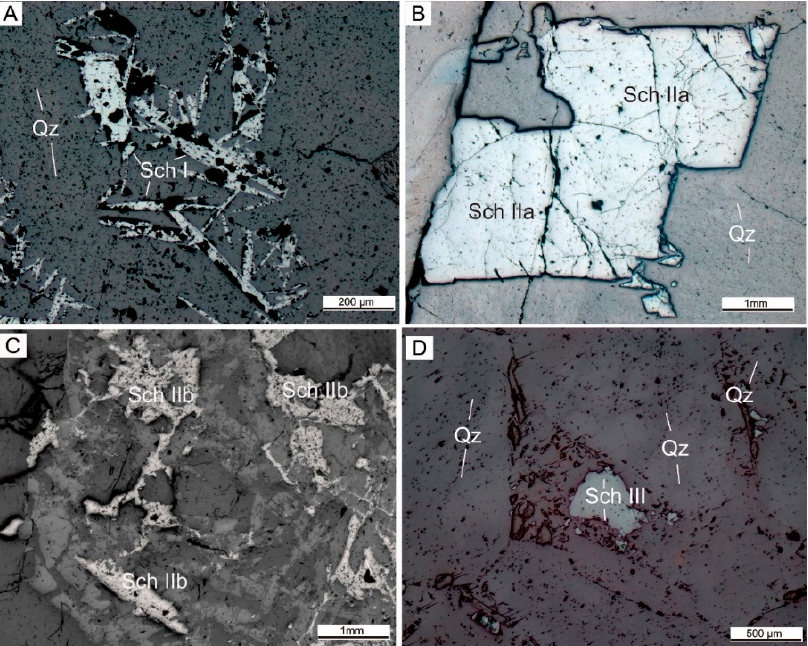
Figure 4. Typical ore texture under microscopy showing scheelite from the Chuankou tungsten deposit. ( A ). Wolframite partly replaced by scheelite; ( B ). Coarse grain Euhedra scheelite grain; ( C ). Wolframite replaced by scheelite along the edge of wolframite; ( D ) Disseminated scheelite distributed in the quartz matrix. Abbreviation: Sch-scheelite; Qz-quartz.